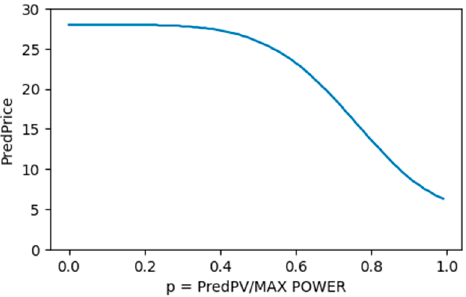
Figure 3. Relationship between generation rate and predicted price.